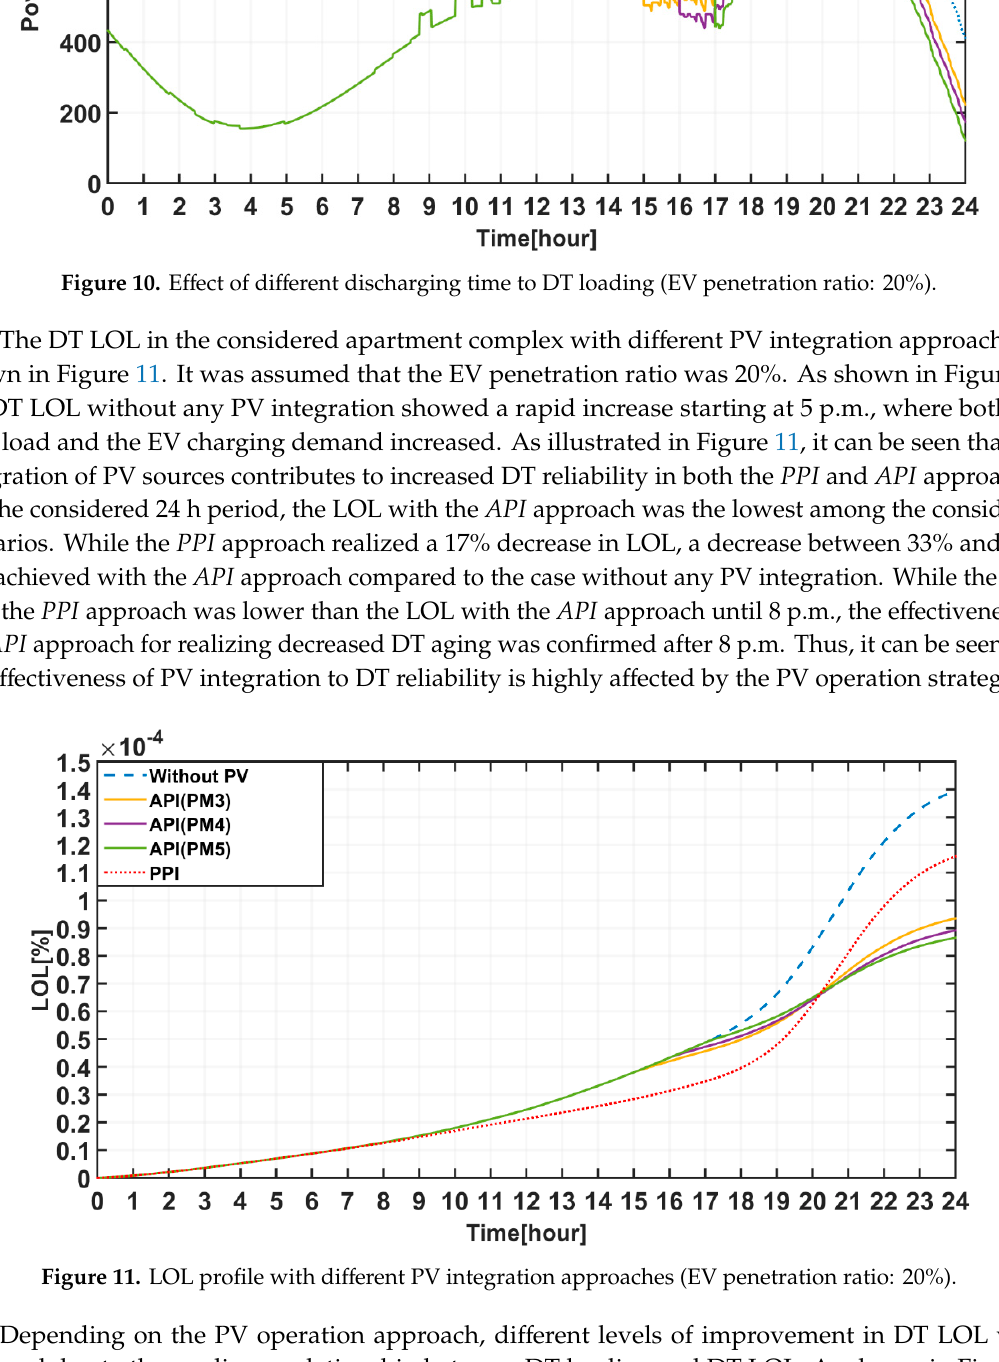
Figure 11. LOL profile with different PV integration approaches (EV penetration ratio: 20%).